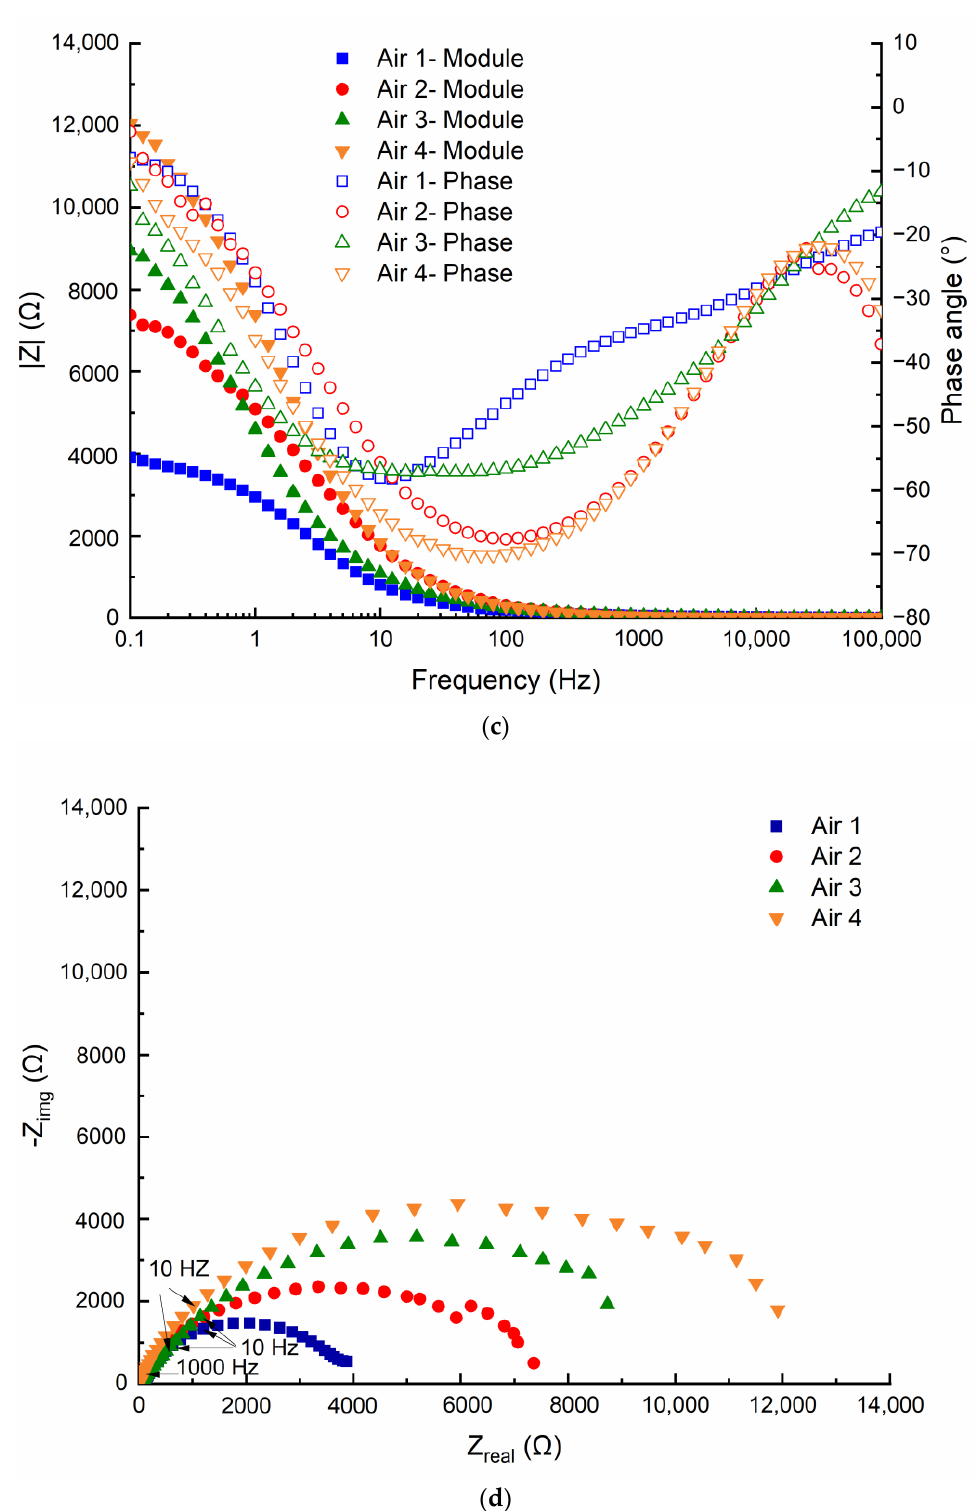
Figure 8. The EIS results of the block ( a ) Bode water-quenched part, ( b ) Nyquist water-quenched part, ( c ) Bode air-cooled part, ( d ) Nyquist air-quenched part.